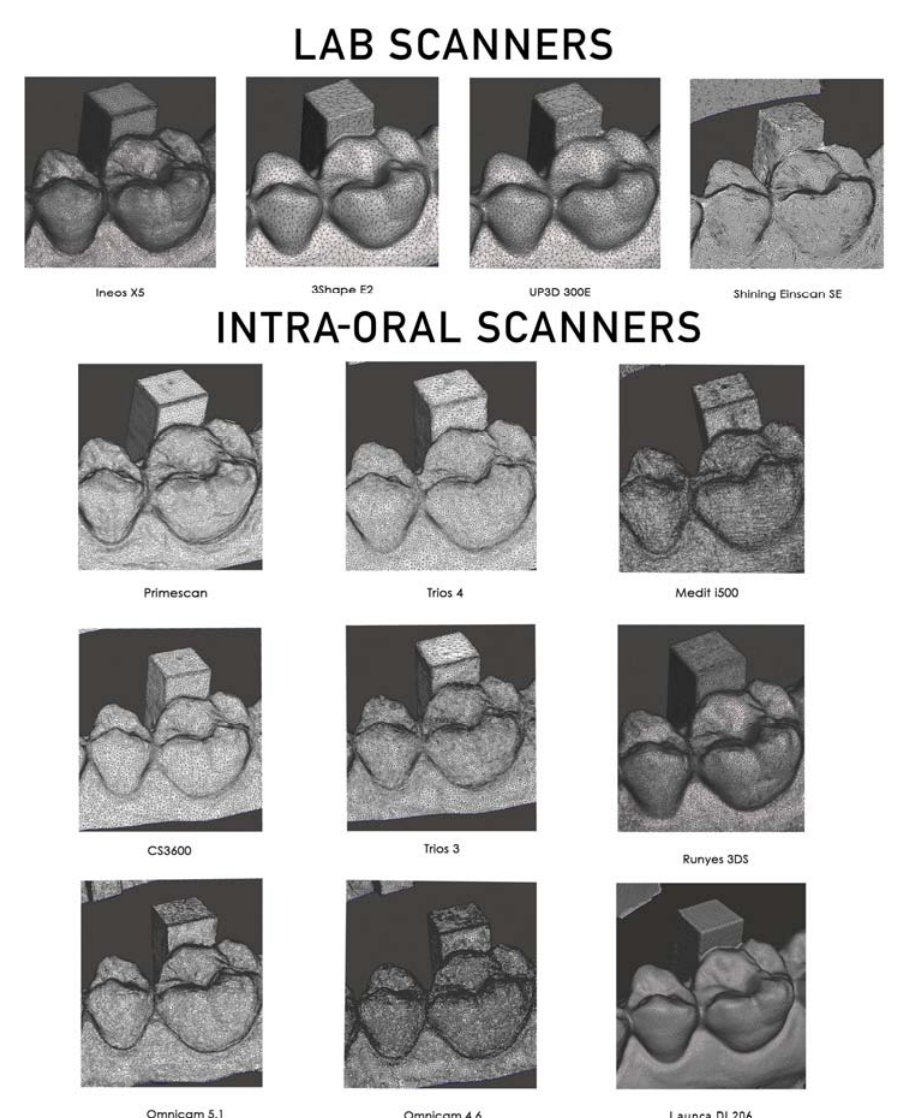
Figure 6. Comparison of triangular meshes.